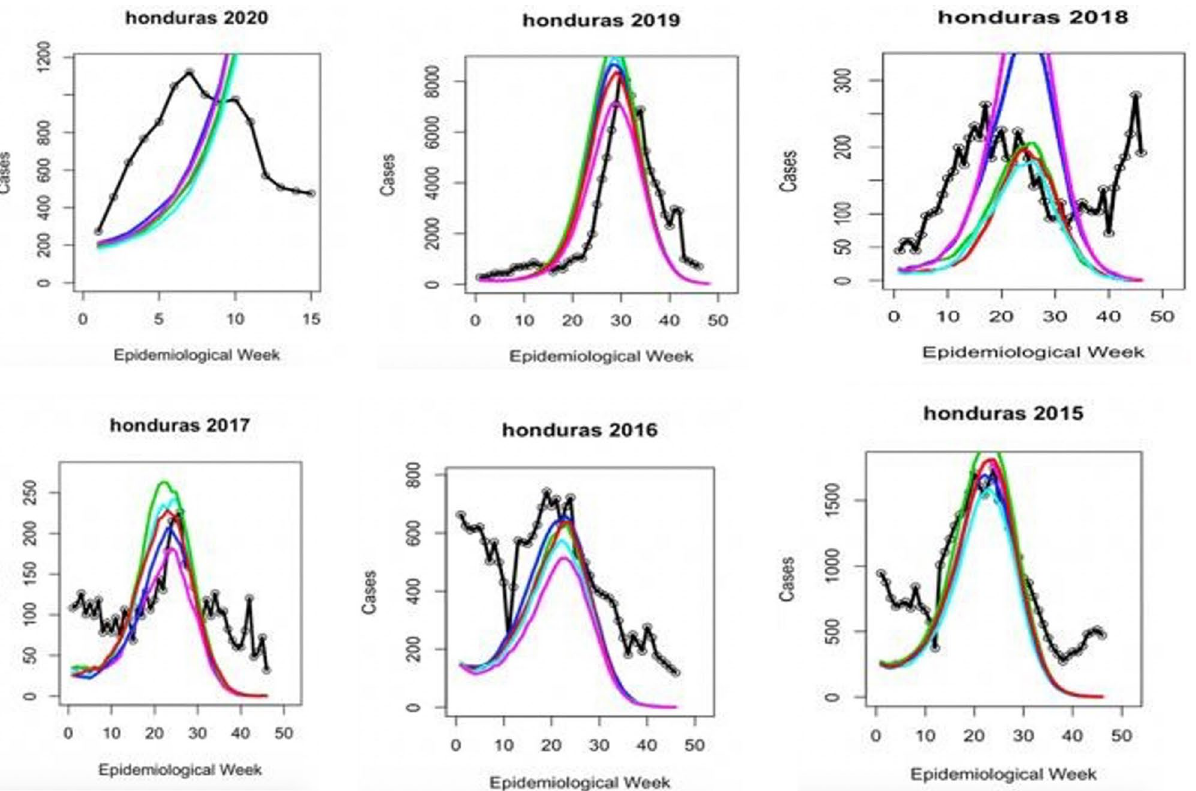
Figure 3. Graph exhibiting the results of seasonal model testing for Honduras yearly outbreaks. Colored lines represent five different forward simulation runs. Solid black line is the reported case count for each year.